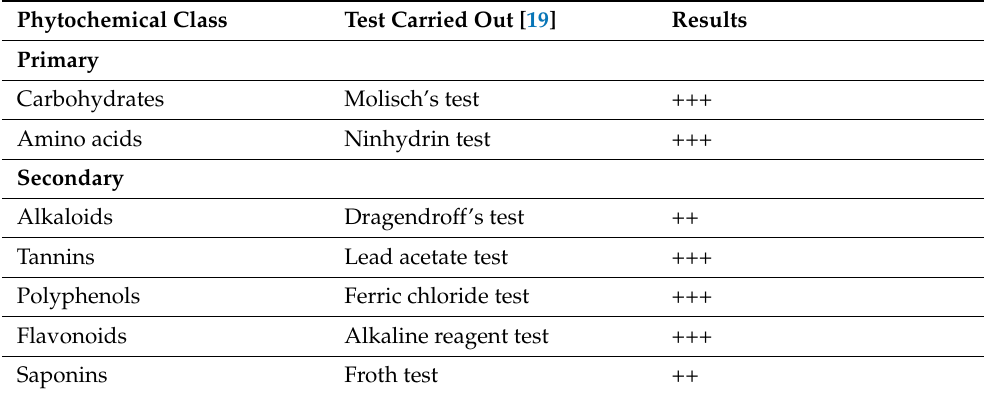
Table 1. Classes of compounds detected in the ethanolic extract of Z. pentandra in preliminary phytochemical